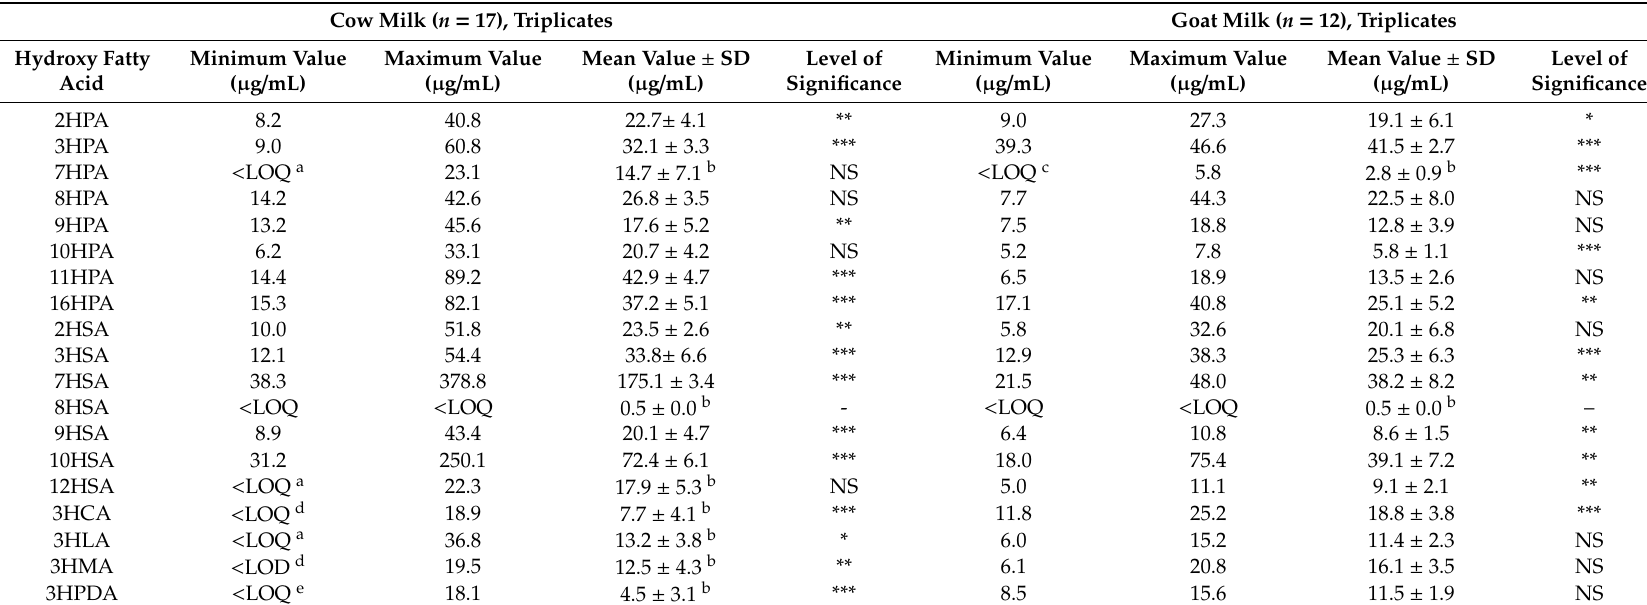
Table 4. Contents of free hydroxy fatty acids in cow milk and goat milk samples ( µ g / mL fresh milk). Cow Milk ( n = 17), Triplicates Goat Milk ( n = 12),